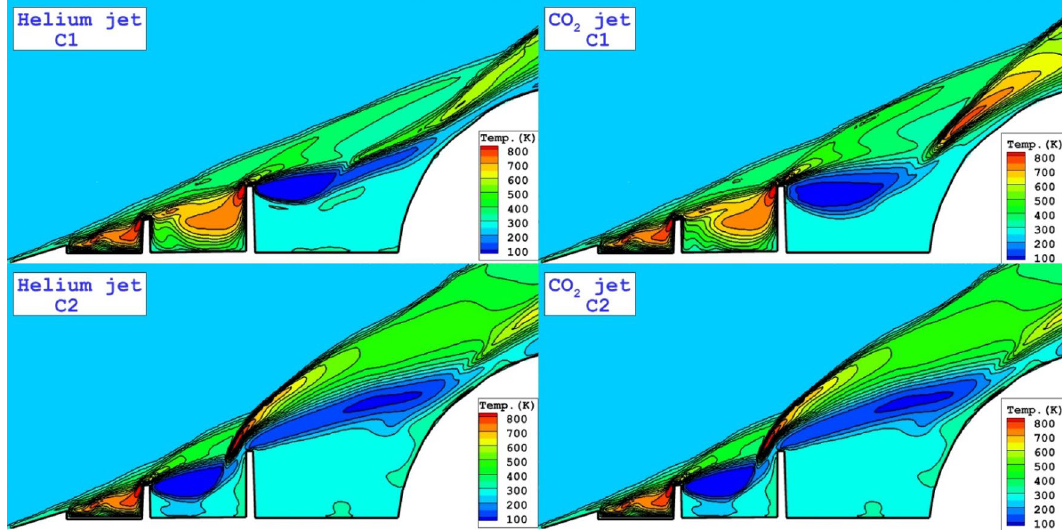
Figure 6. Comparison of temperature for the injection system from the tip of disks.